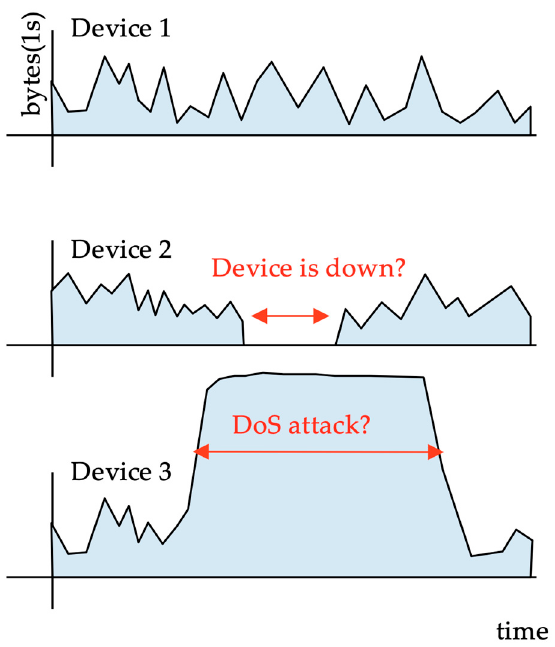
Figure 1. A disconnected device is detected using the traffic it generates.